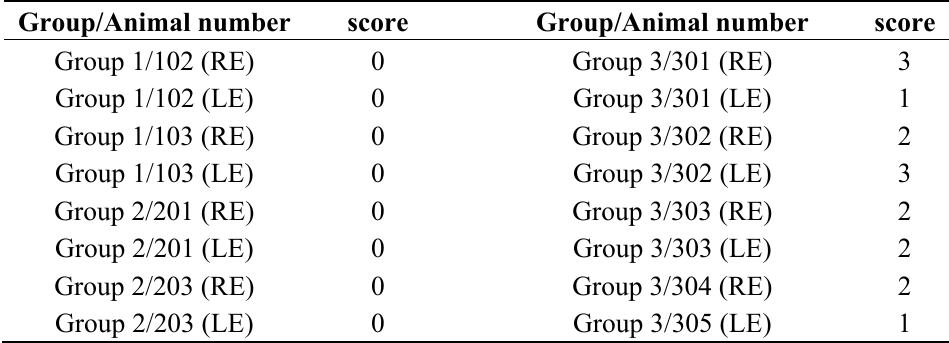
Table 1. Histological inflammatory scores in vitreous (Group 1/Vehicle, Group 2/Low dose: 20 µg/eye, Group 3/High dose: 100 µg/eye. RE: right eye, LE: left eye). Score: 0 = no inflammation, 1 = minimal inflammation, 2 = mild inflammation, 3 = moderate inflammation, 4 = severe